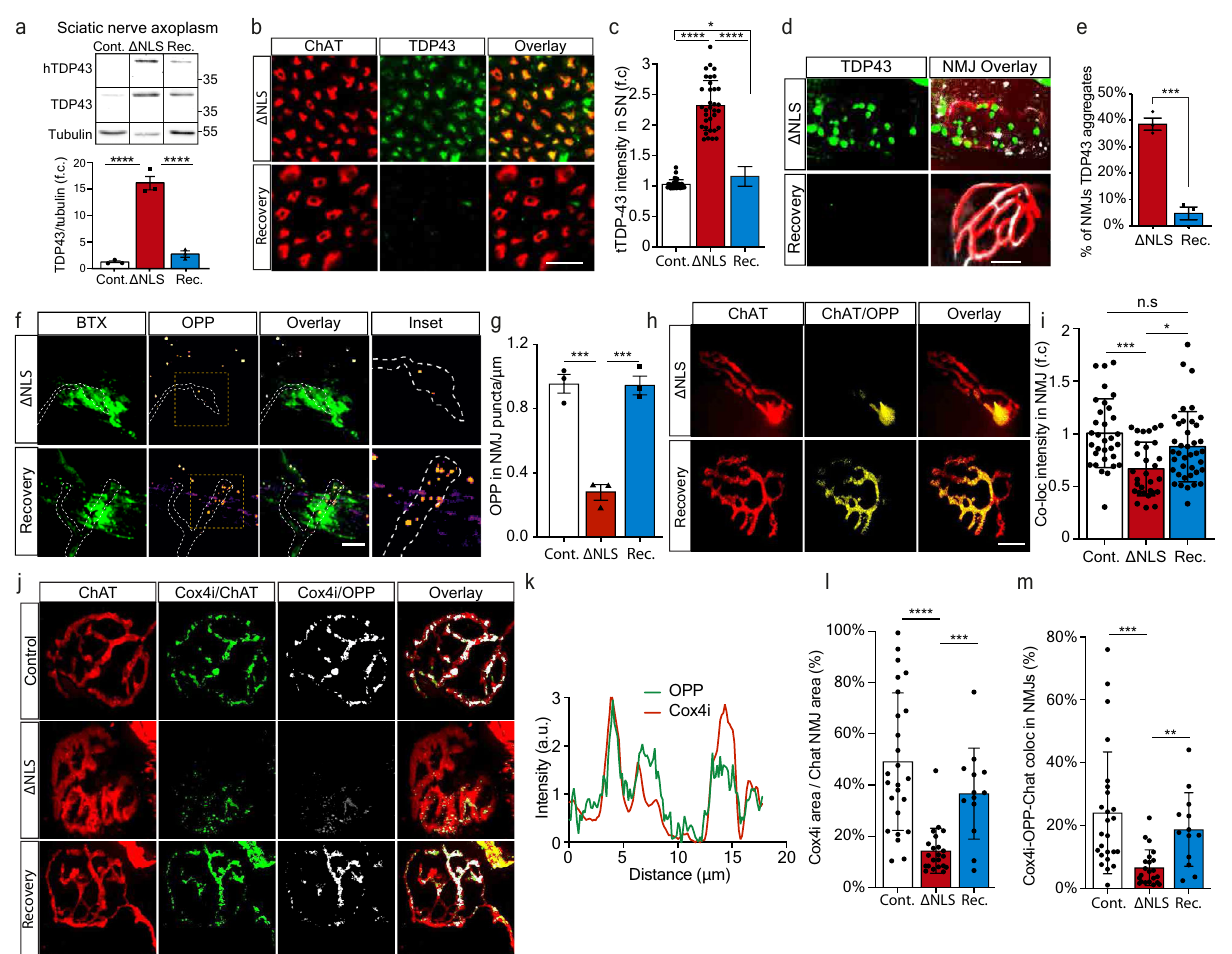
Fig. 7 Restoring TDP-43 localization recovers local translation of mitochondrial proteins in distal axons and the NMJs. a Western-blot and quanti fi cation of TDP-43, hTDP-43 levels in sciatic axoplasm of control, TDP Δ NLS, and recovered-TDP Δ NLS (Rec.). Tubulin was used as loading control. n = 3,3,3 mice. Data are presented as mean values ± SEM. One-way-ANOVA with Holm-Sidak correction. **** p < 0.0001. b Images and c quanti fi cation of TDP-43 intensity within ChAT-positive axons in sciatic nerve sections of control, TDP Δ NLS, and recovered-TDP Δ NLS mice. Scale bar = 20 µ m. n = 34,34,33 images from 3 mice of each condition. Data are presented as mean values ± SD. One-way-ANOVA with Holm-Sidak correction * p = 0.0412, **** p < 0.0001. d Images and e quanti fi cation of the percent of NMJs with apparent TDP-43 condensates in control, TDP Δ NLS, and recovered-TDP Δ NLS mice. Scale bar = 10 µ m. n = 3,3,3 mice from each condition. Data are presented as mean values ± SEM. Unpaired- t -test, two-sided *** p = 0.0001. f Images and g analysis of OPP puncta density in in-vitro NMJs of control, TDP Δ NLS and Recovered-TDP Δ NLS co-cultures. Scale bar = 5 µ m. n = 3 independent repeats. Data are presented as mean values + SEM. One-way-ANOVA with Holm-Sidak correction. *** p = 0.0004 (left), *** p = 0.0004 (right). h Images and i analysis of the OPP labeling intensity in pre-synaptic NMJs of control, TDP Δ NLS and recovered-TDP Δ NLS mice. n = 32,30,39 NMJs, from 3,3,3 mice. Scale bar = 10 µ m. Data are presented as mean values ± SD. One-way-ANOVA with Holm-Sidak correction. * p = 0.019, *** p = 0.0001. j Images and k representative channel histograms of Cox4i and OPP intensities within pre-synaptic axon (ChAT) in NMJs of control TDP Δ NLS mice, l – m quanti fi cation of Cox4i area ( l ), and of Cox4i-OPP coloc-area within pre-synaptic axons (ChAT) in NMJs of control, TDP Δ NLS, and recovered-TDP Δ NLS mice. Scale bar = 10 µ m. n = 23,21,13 NMJs. 3,3,3 mice. Data are presented as mean values ± SD. One-way-ANOVA with Holm-Sidak correction. **** p <